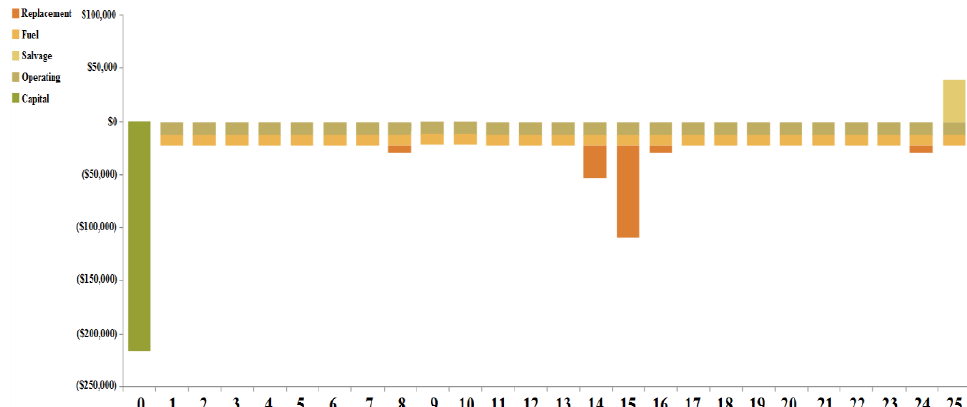
Figure 29. Totalcash-flow study for case IV (Ba/Bi/H/S).